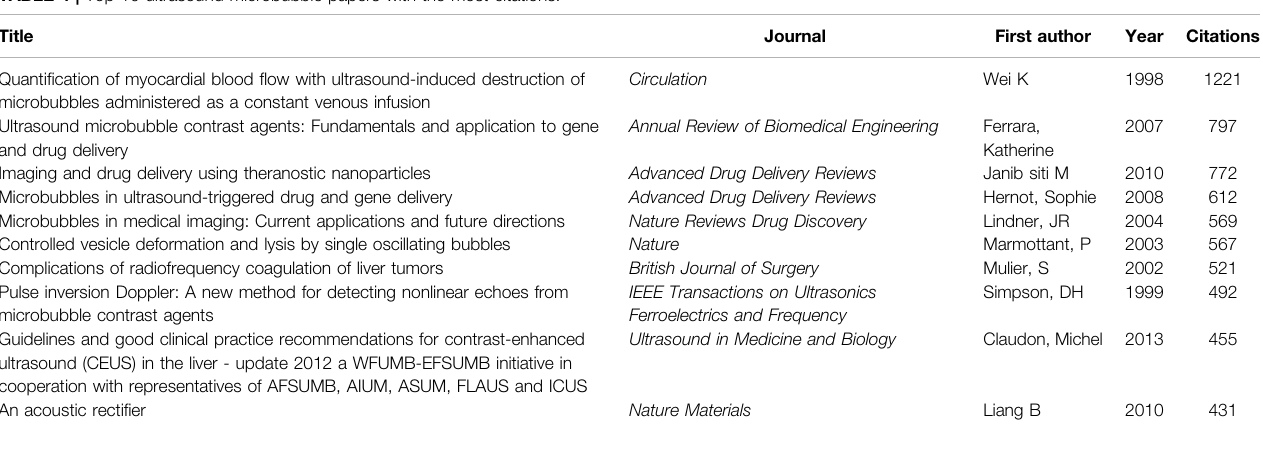
TABLE 4 | Top 10 ultrasound microbubble papers with the most